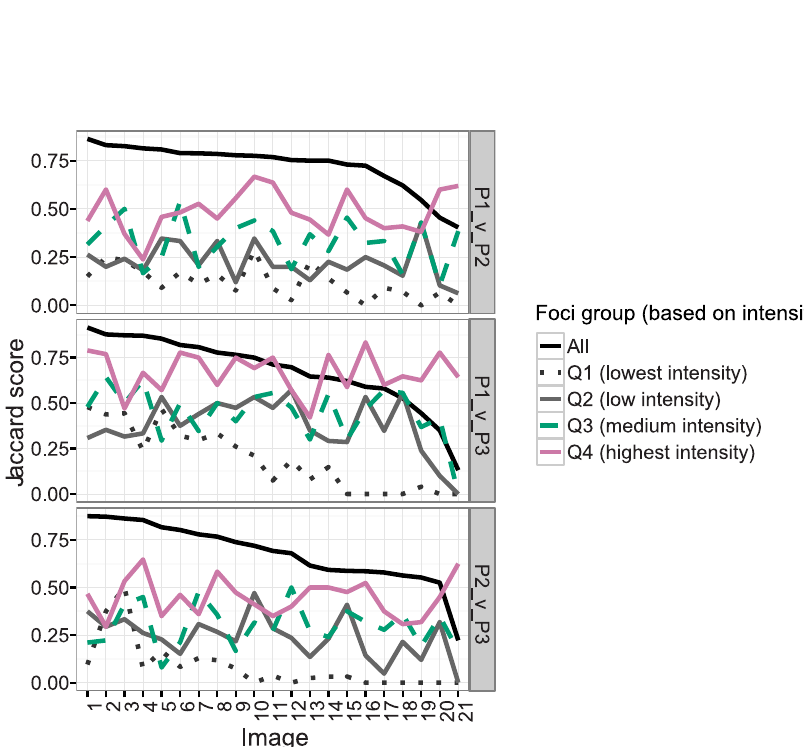
Figure 5. Agreement of focus selection between any two experimenters decreases with reduced focus intensity. Foci were arranged by pixel intensity and divided into quartiles. The match statistics (Jaccard scores) were computed for each quartile (Q1–Q4) and the entire set (‘All’). Images are arranged in descending order of overall Jaccard score. Q1 consisted of the 25% of foci with the lowest intensity, Q2 the 26 th –50 th percentile (‘low intensity’); Q3 the 51 st –75 th percentile (‘medium intensity’), and Q4 the 25% of foci with the highest intensity (‘highest